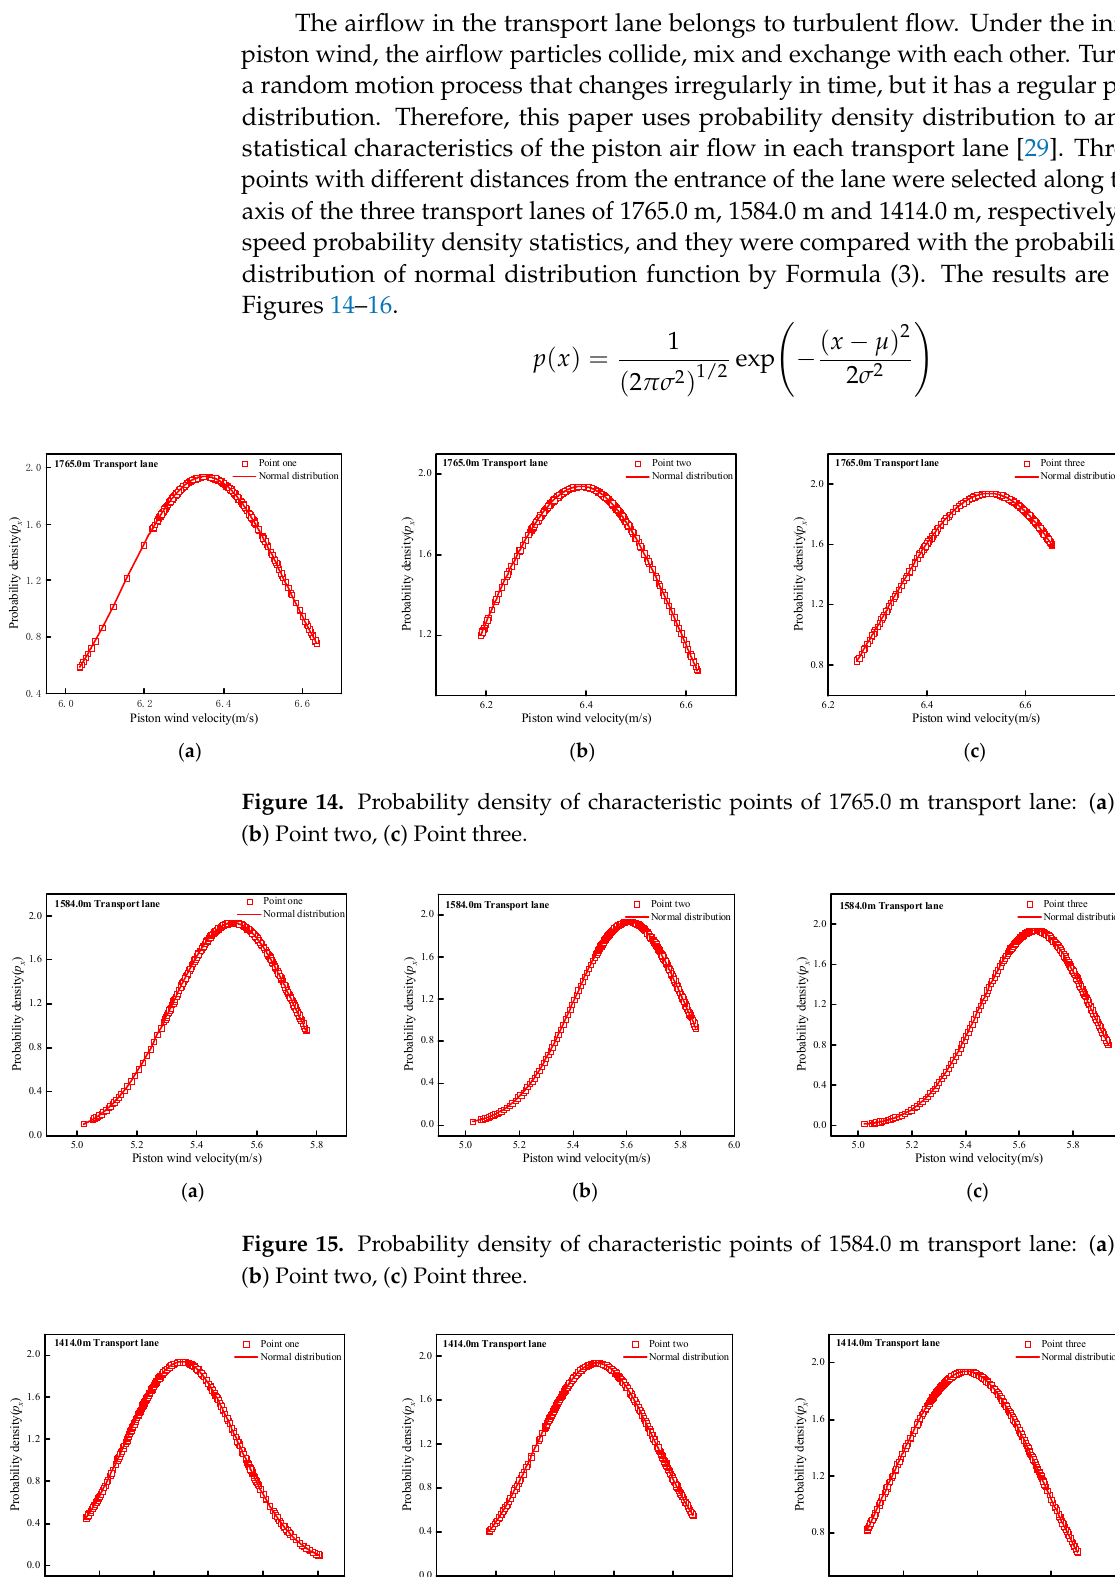
Figure 13. The pressure difference of measuring points in each transport lane.